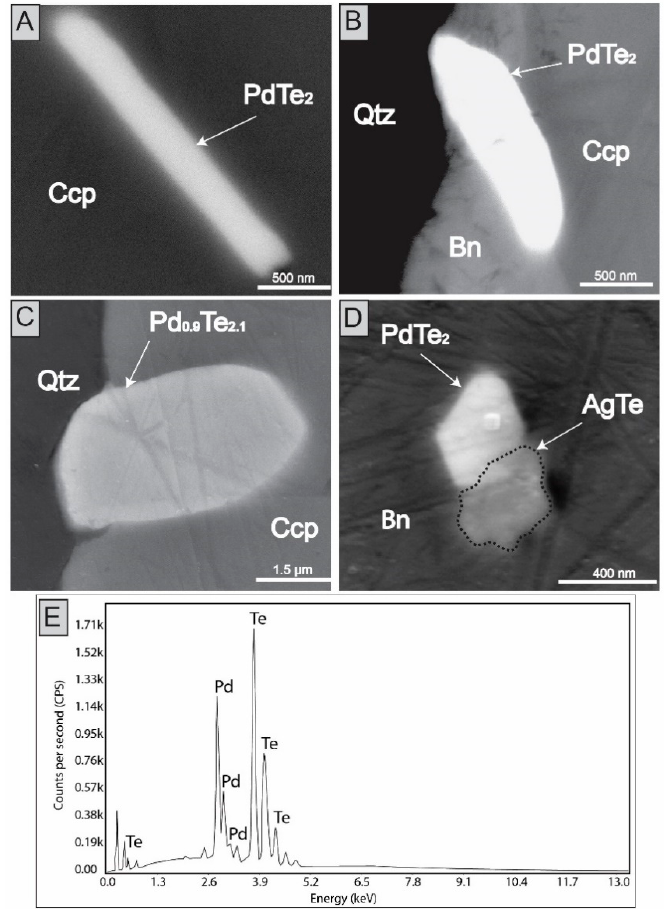
Figure 2. Field-emission scanning electron microscopy (FESEM) images of platinum group minerals (PGM) in chalcopyrite and bornite from Río Blanco. Palladium tellurides are shown in images ( A – D ). Images ( A , B ) were taken using the back-scattered electron detector (BSE), while images ( C , D ) were taken using the secondary electron (SE) detector. ( E ) shows the energy-dispersive X-ray spectrometer (EDS) spectrum of the Pd telluride grain in image ( C ). Ccp: chalcopyrite, Bn: bornite, Qtz: quartz, AgTe: silver telluride, PdTe 2 : merenskyite.